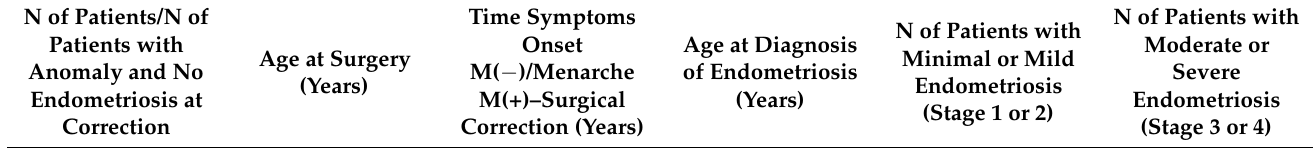
Table 4. Characteristics of six adolescents diagnosed with endometriosis during follow-up. N: number; M( − )—in adolescents with cryptomenorrhea; and M(+)—in adolescents with menses.